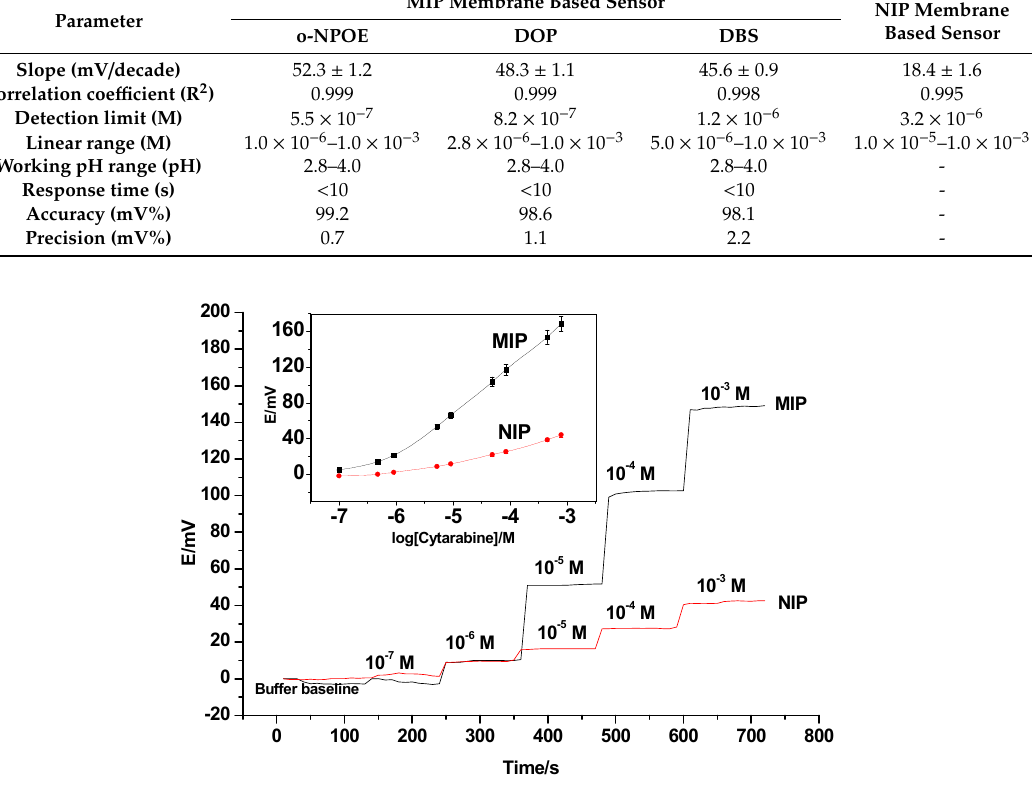
Figure 4. Potentiometric behavior of the cytarabine-membrane-based sensor (time trace and potentiometric response).